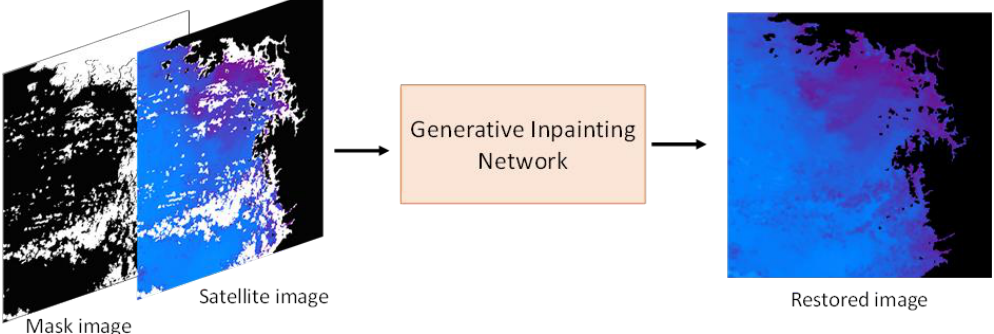
Figure 3. Proposed GIN model takes a pair of occluded SST and corresponding binary mask image as input and outputs a restored image without modifying the nonoccluded region.